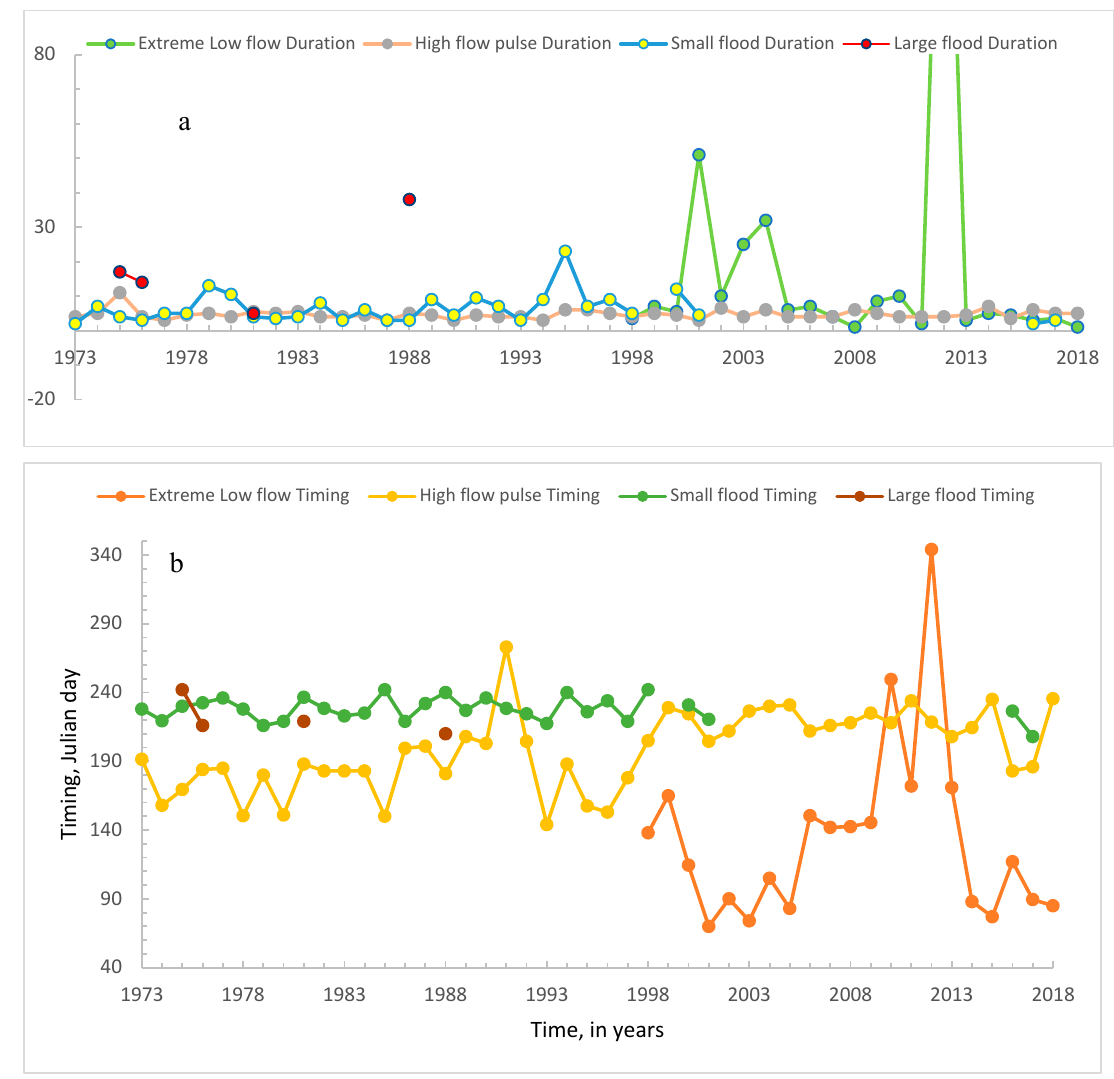
Figure 12. Duration ( a ) and Timing ( b ) of environmental flow components. Duration is the number of days a given flow component occurred and Timing is the Julian date when a given flow component occurred. Note. The Duration ( a ) in 2012 is 200 days.